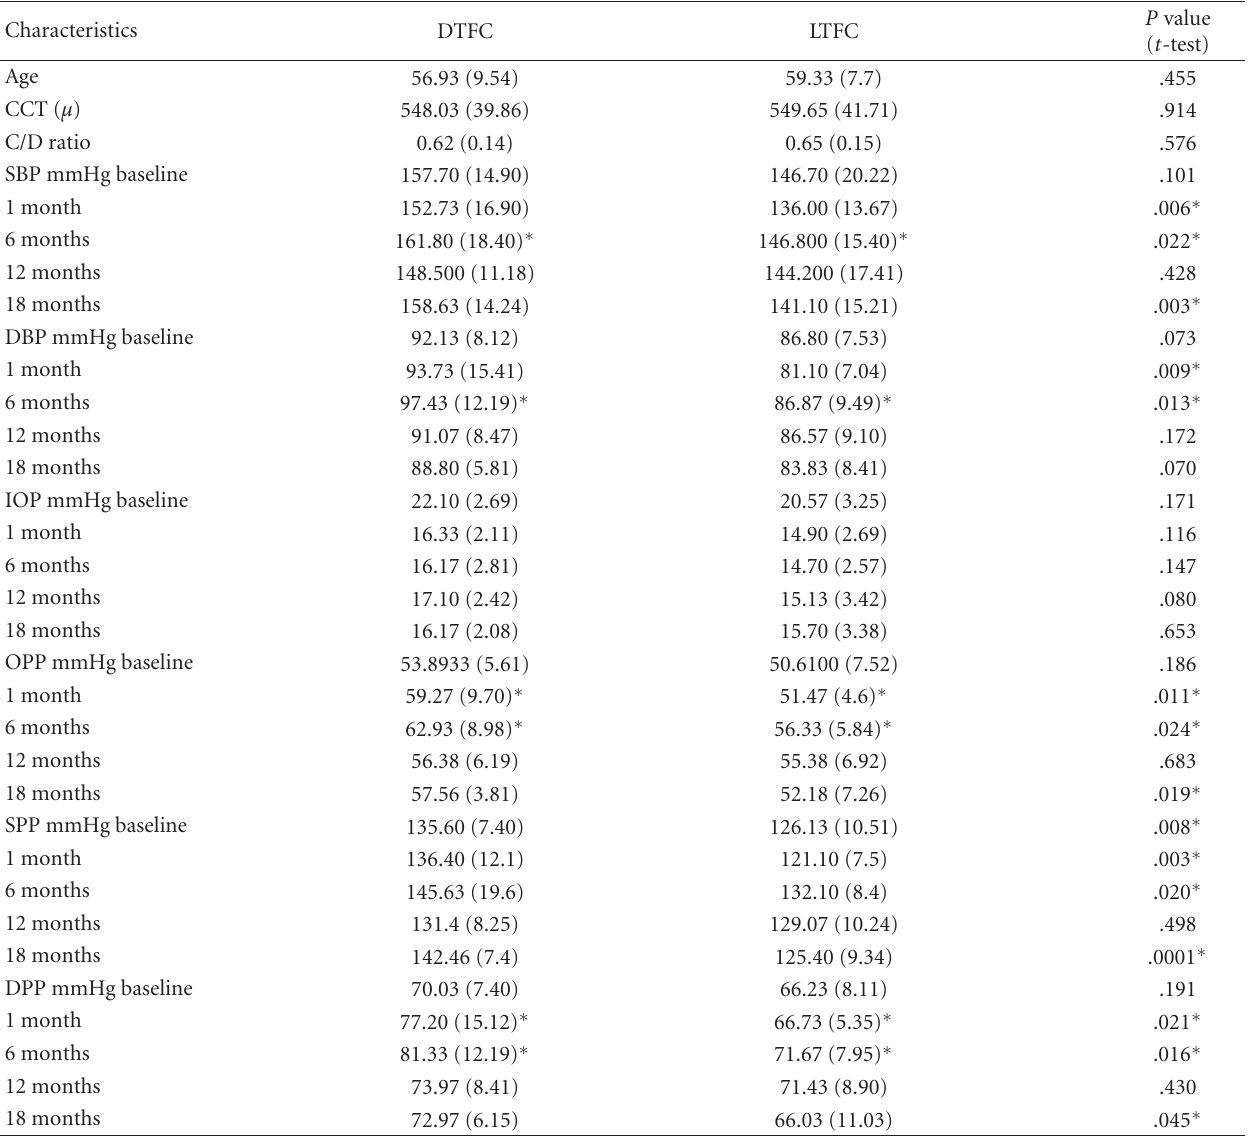
Table 1: Comparison of characteristics of patients treated with DTFC and